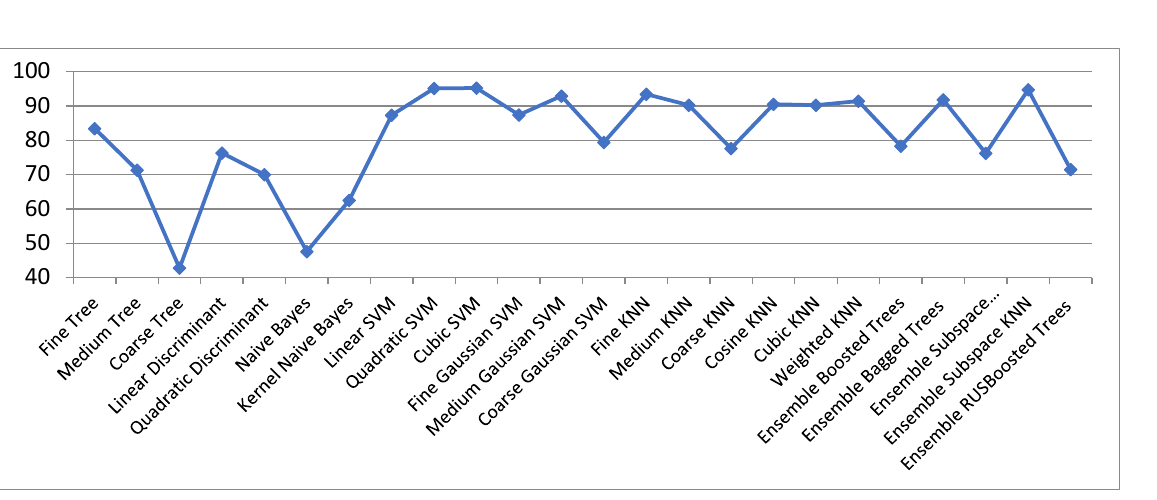
Figure 2. Classification rate in the original ECG space (centered 301 samples segments). Table 1. Classification accuracies with CS, LE, LPP algorithms for 2, 3 and 25 dimensions respectively. ECG Original Centered Compressed Sensed (CS) Laplacian Eigenmaps (LE)